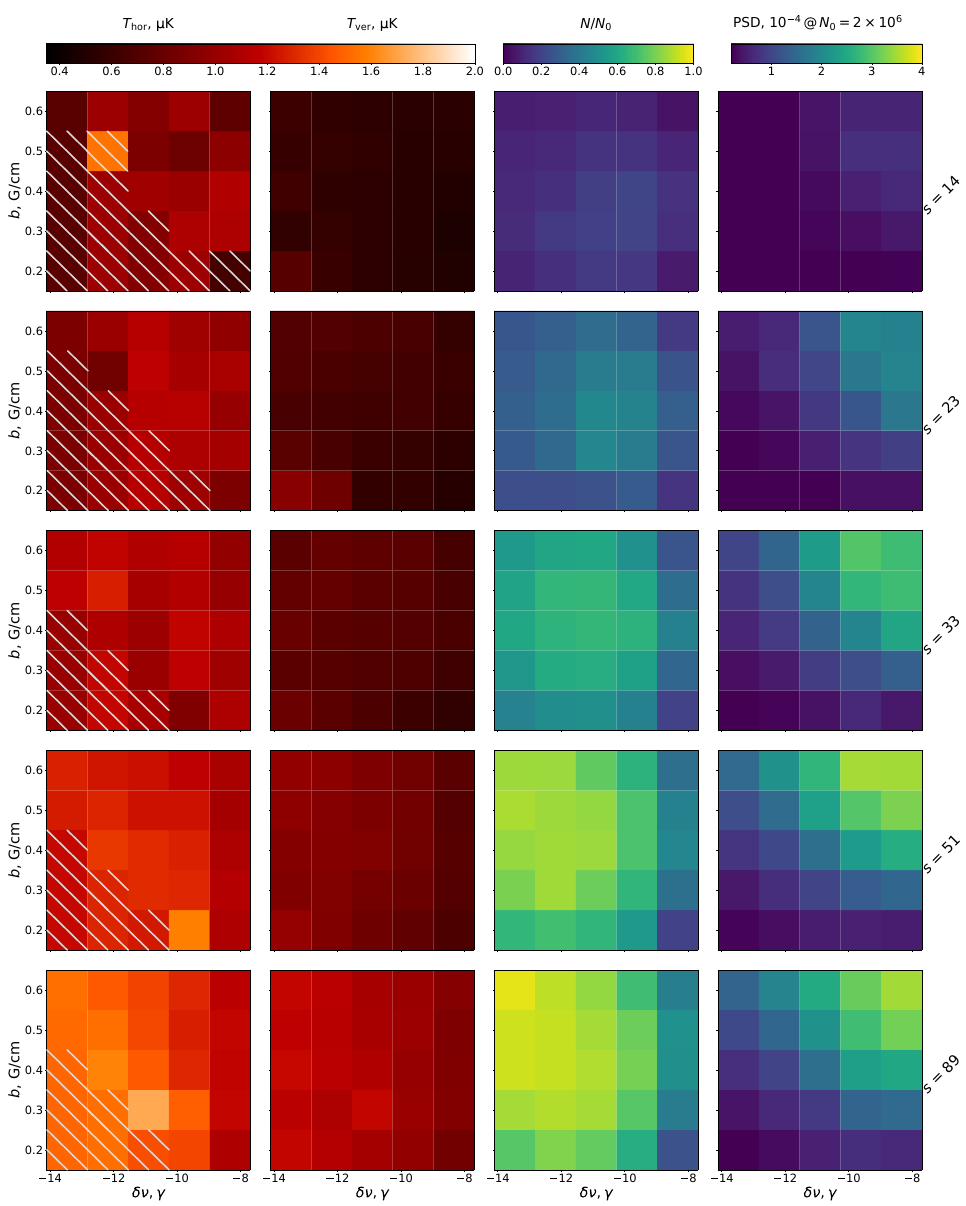
Figure 2. Results of MOT optimization process for several input parameters: magnetic field gradient ( b , y -axis), frequency detuning ( δν , x -axis), and total intensity of 506.2nm MOT beams in the units of saturation parameter ( s , rows). Four columns represent four key parameters: two temperatures of atomic cloud ( T hor along the horizontal plane and T ver along the vertical direction), phase-space density ( PSD ), and relative number of atoms ( N / N 0 , where N 0 = 2 10 6 —the number of atoms × in MOT after first stage cooling). Bowl-shaped cloud in the region of high detunings and low magnetic field gradient complicates temperature measurement in the horizontal plane. This area gives unreliable results for the horizontal temperature and is marked by the white lines crossing this